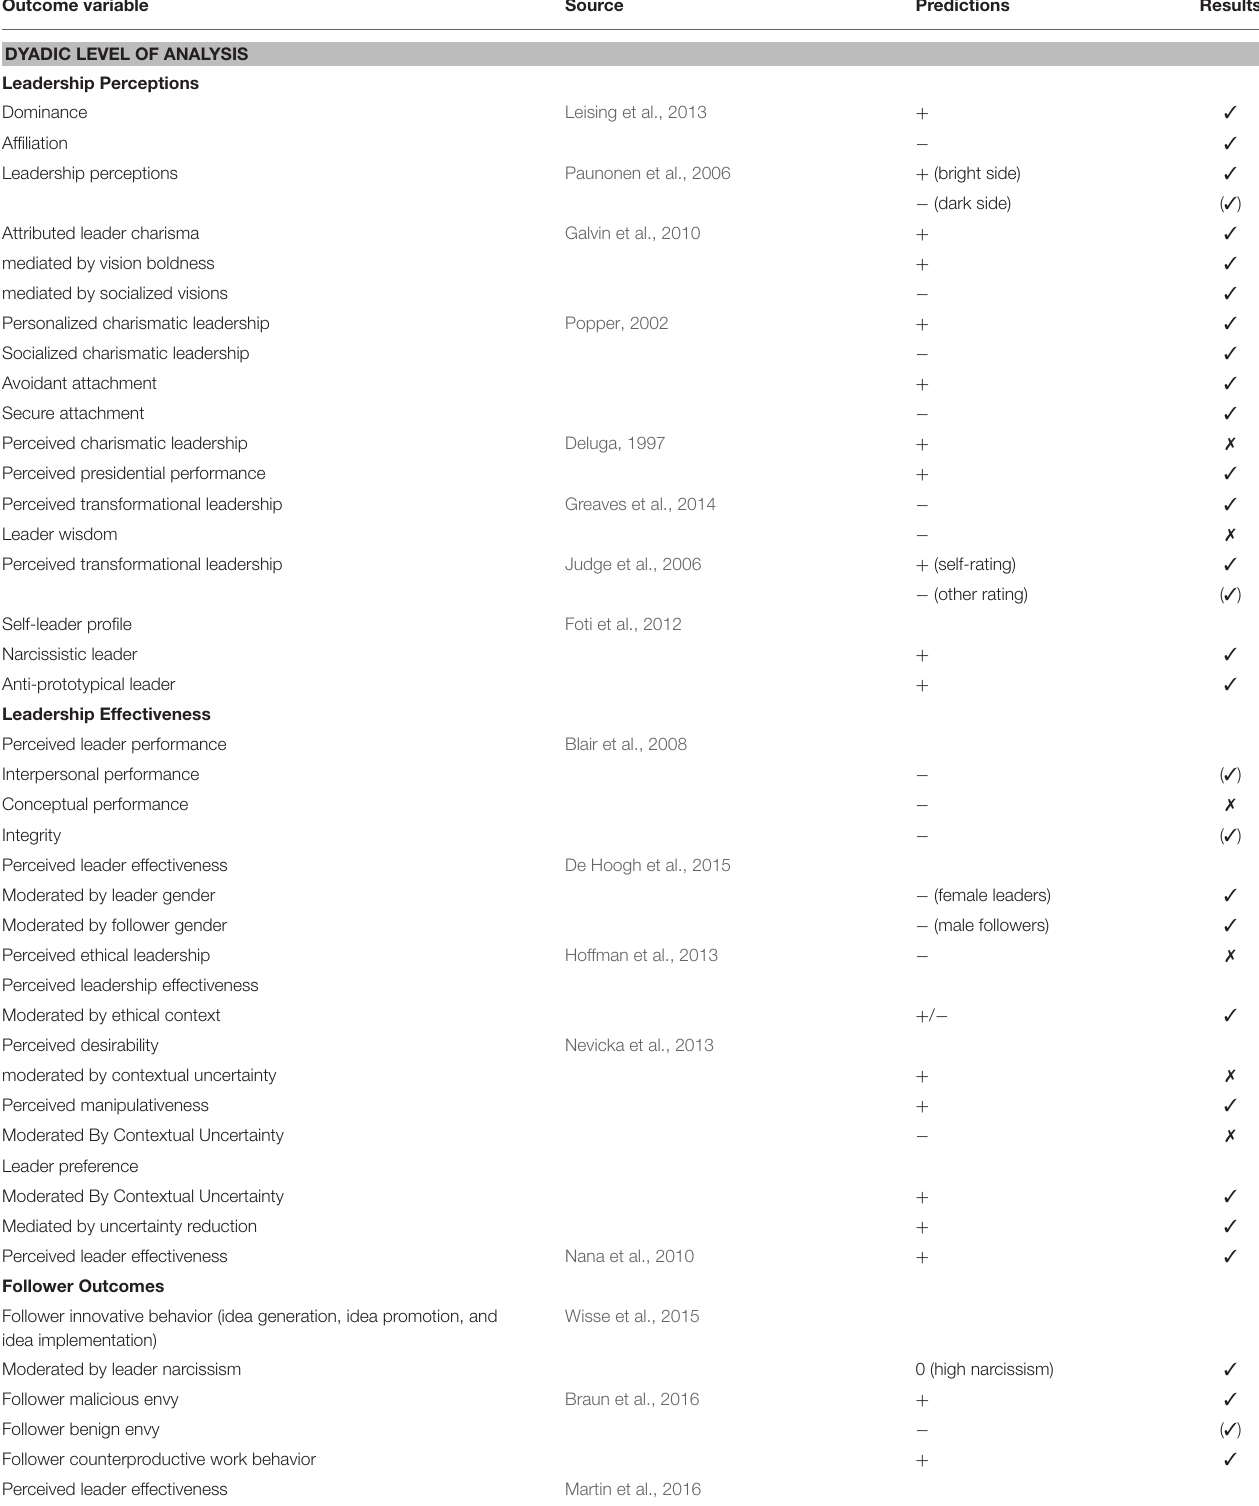
TABLE 3 | Summary of the empirical evidence for the outcomes of leader narcissism at dyadic, team, and organizational levels of analysis Outcome variable Source